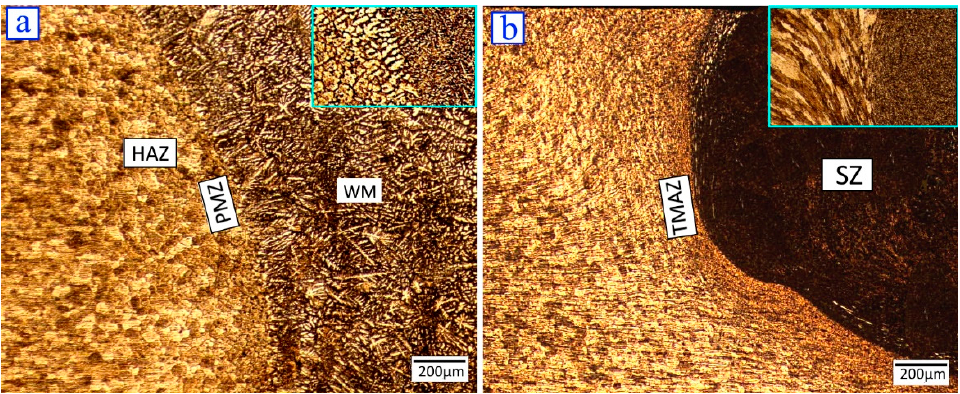
Figure 4. Optical micrographs of the weld: ( a ) unprocessed and ( b ) processed with FSP.